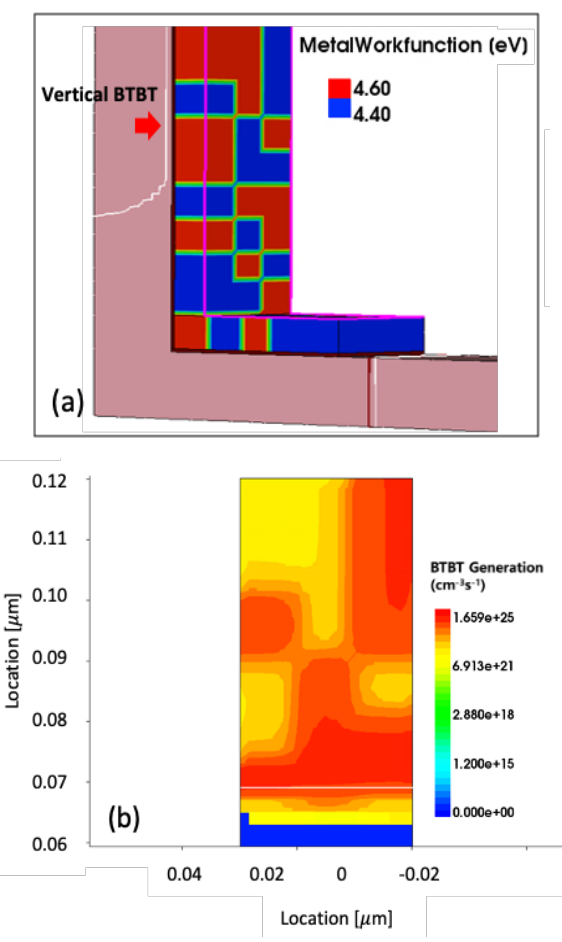
Figure 3. ( a ) TiN-grains distribution in gate area ( b ) BTBT rate on source region. The vertical-BTBT generated in the source area can be found to be high.